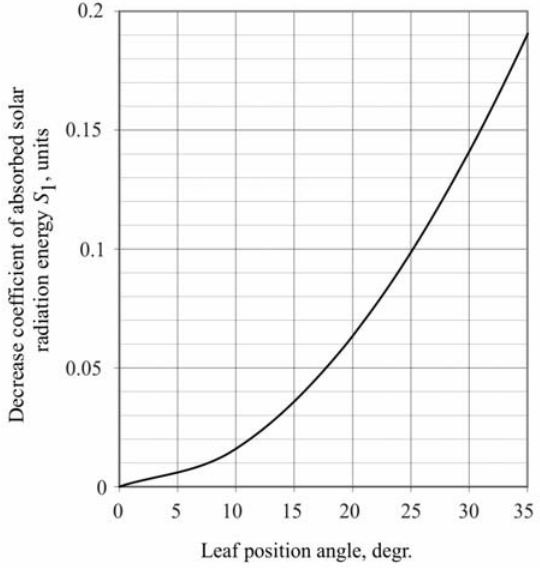
Fig. 4. Dependence of the decrease coefficient of the absorbed solar radiation energy S 1 on leaf position angle β (Fig.